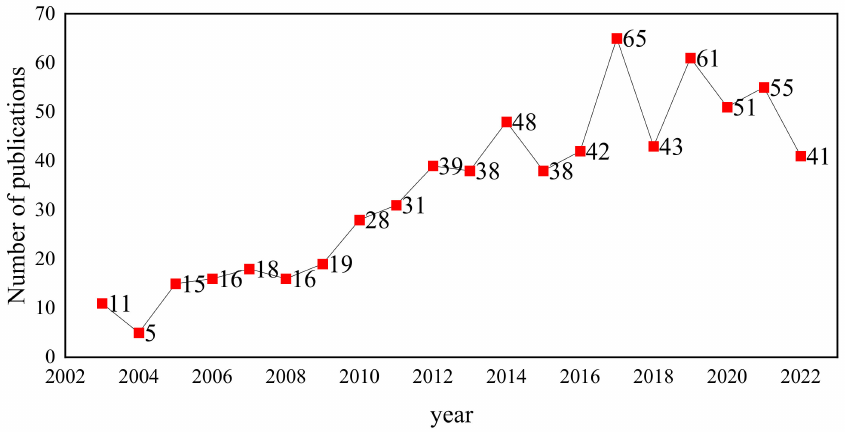
Figure 16. The growth trend of relevant literatures from 2003 to